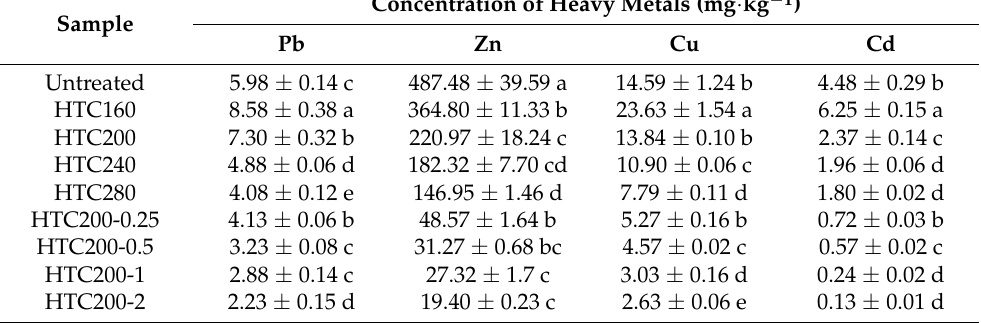
Table 1. Concentration (mg·kg − 1 ) of heavy metals in hydrochar formed by HTC at different HCl concentrations.